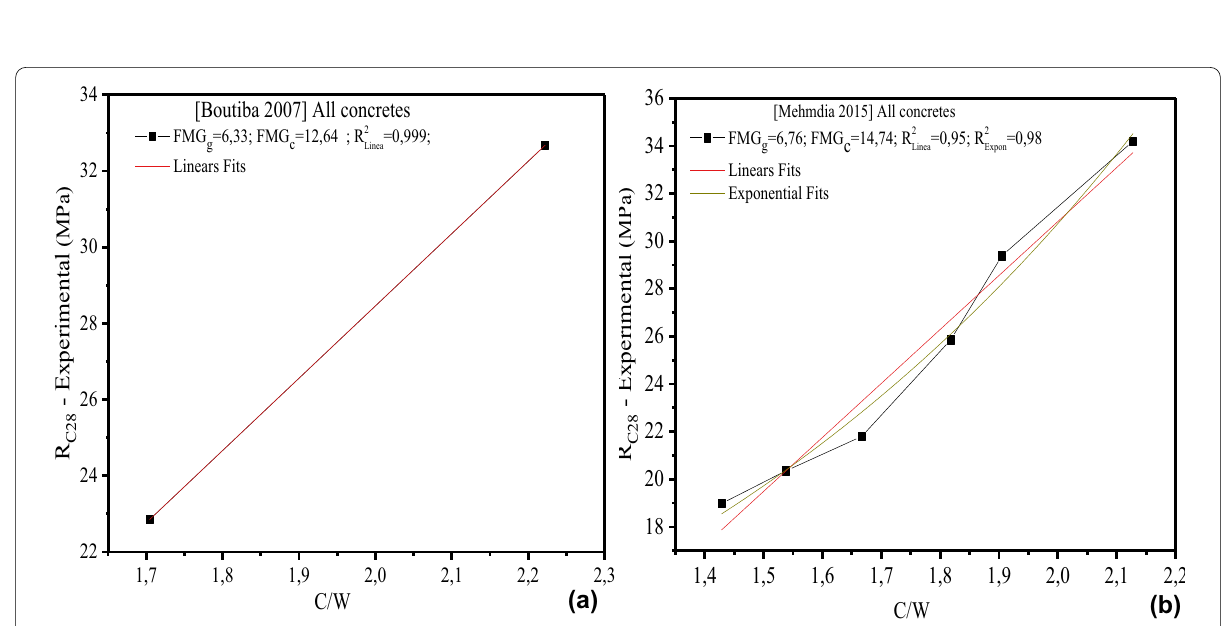
Fig. 16 Evolution of R C28 as a function of the ratio C / W , (Boutiba et al. 2014., Mehamdia and Benouis (2018). a Results given by FGM g and FGM C (Boutiba), b results given by FGM g and FGM C